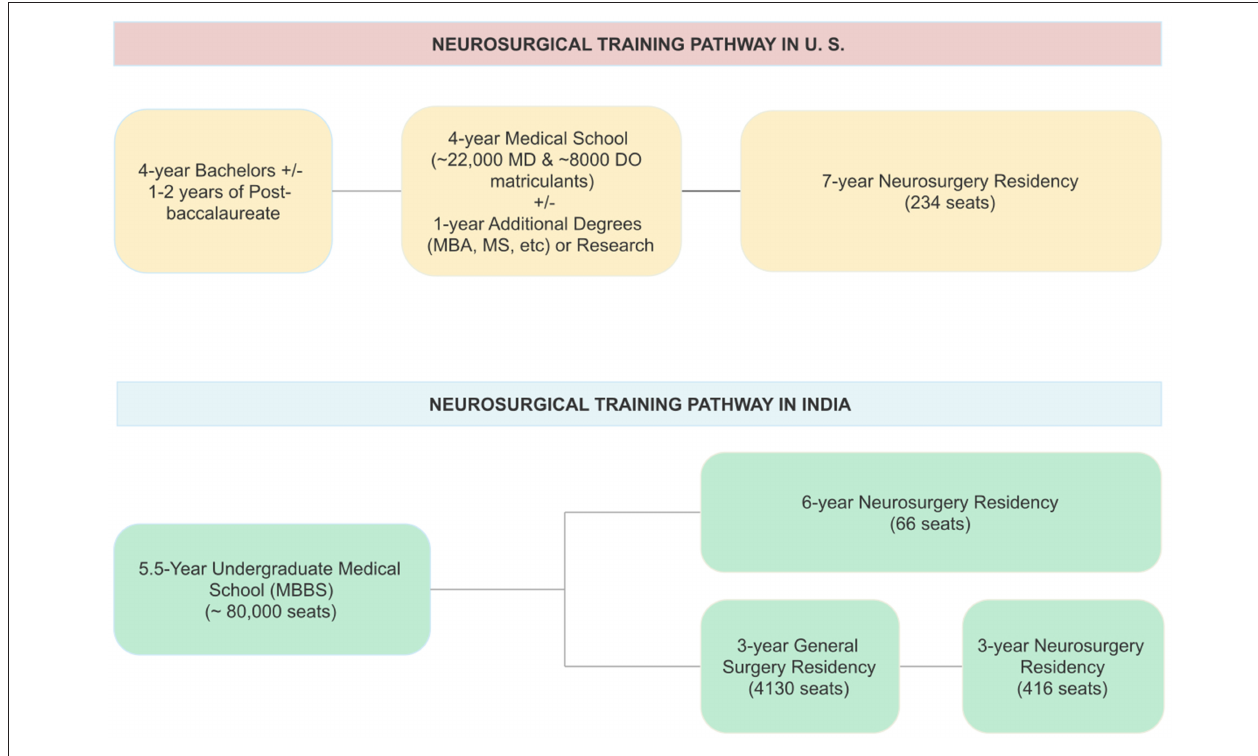
FIGURE 1 | Comparison between the United States and India of training lengths and positions for the training of a neurosurgeon. Seat numbers in India are sum totals for programs accredited by either National Medical Council (NMC) or National Board of Examinations (NBE) in India.